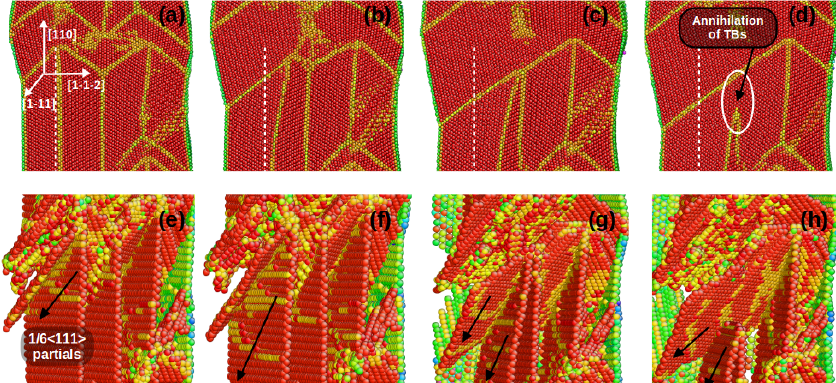
Figure 4. The annihilation of pre-existing twin boundary due to the bending and subsequent migration of pre-existing twin boundaries ( a – d ). This process is aided the by the continuous glide of 1/6 < 111 > partial dislocations on the existing TBs. The atoms are coloured according to their centro-symmetry parameter (CSP). For clarity, the atoms in perfect BCC structure were removed in ( e – h